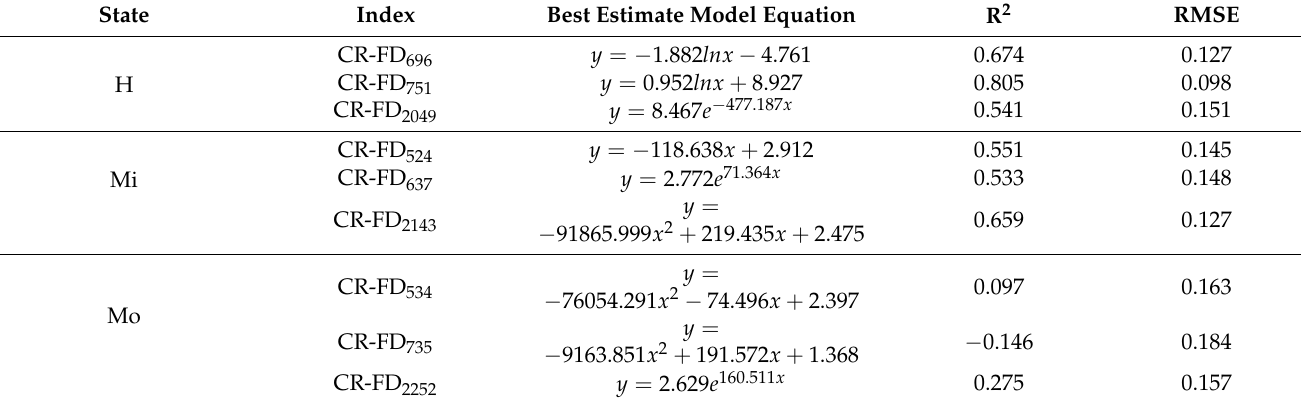
Table 1. Construction of relationship models for Moso bamboo leaves in different damage states.